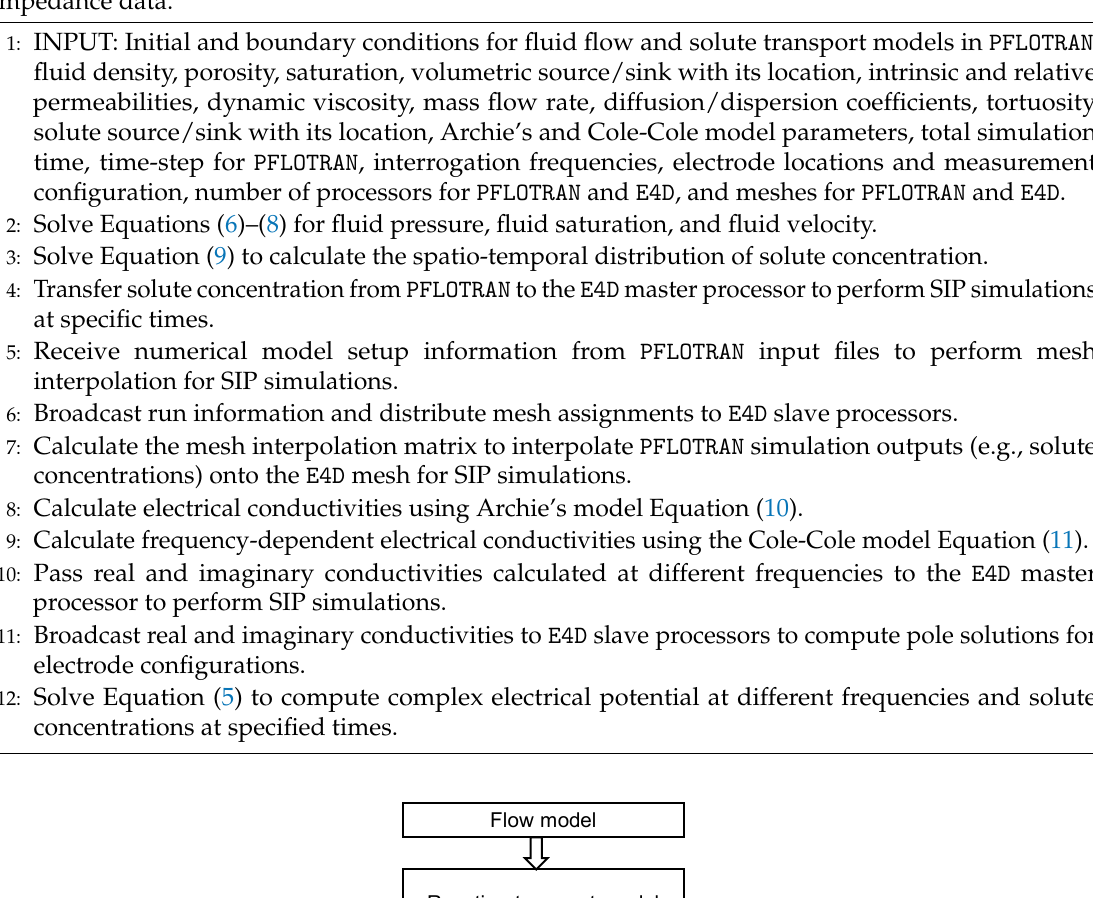
Algorithm 1 Overview of the proposed PFLOTRAN-SIP framework for simulating electrical impedance data.